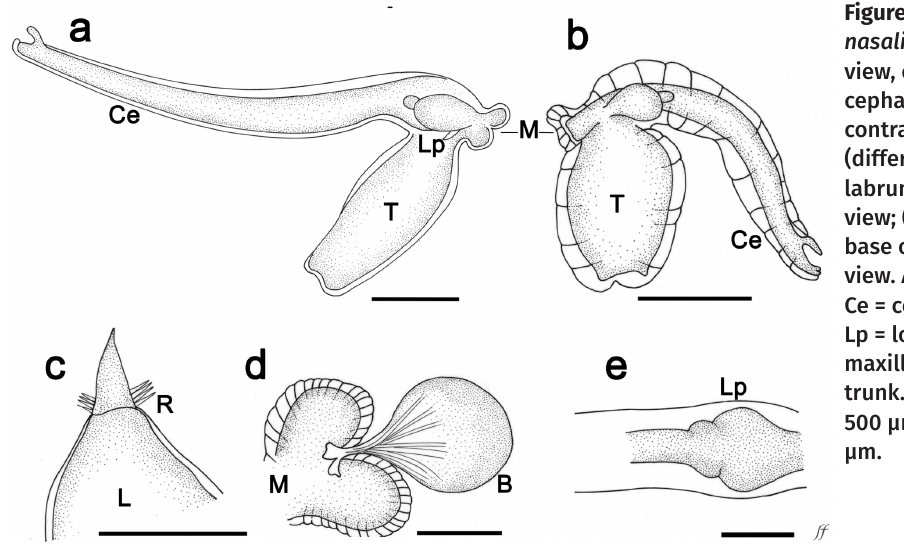
Figure 1. Female Praeclavella nasalis n. gen. et sp., ( a ) Lateral view, completely expanded cephalothorax; ( b ) lateral view, contracted cephalothorax (different specimen); ( c ) labrum and rostrum, dorsal view; ( d ) maxilla and bulla; ( e ) base of cephalothorax, dorsal view. Abbreviations: B = bulla, Ce = cephalothorax, L = labrum, Lp = lobular projection, M = maxilla, R = rostrum, and T = trunk. Scale bars: Fig. a and b= 500 µm, Figs. c, d and e = 25